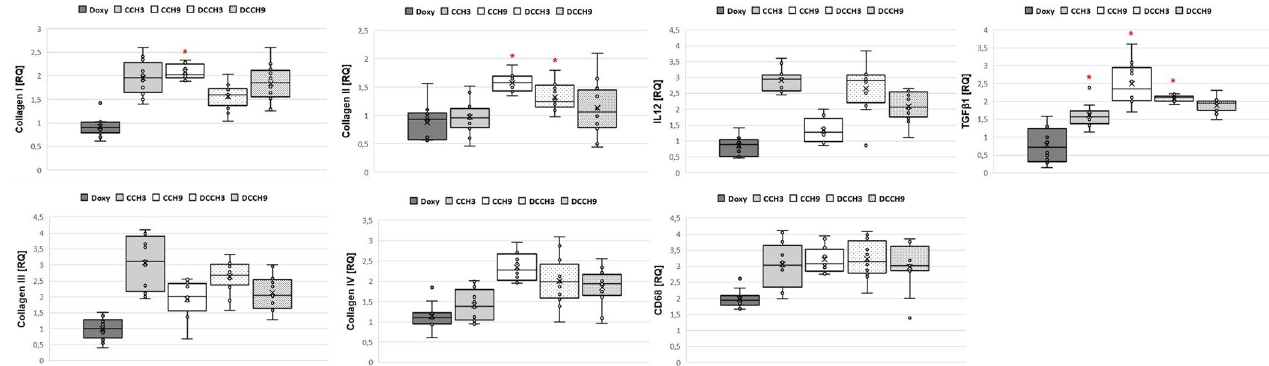
Fig 10. Results of gene expression analysis. Mean values (X) are graphed on a box plot and individual data points are shown. Red Asterix denotes statistically significant differences of study groups compared to control group CG. Group size: n = 12.